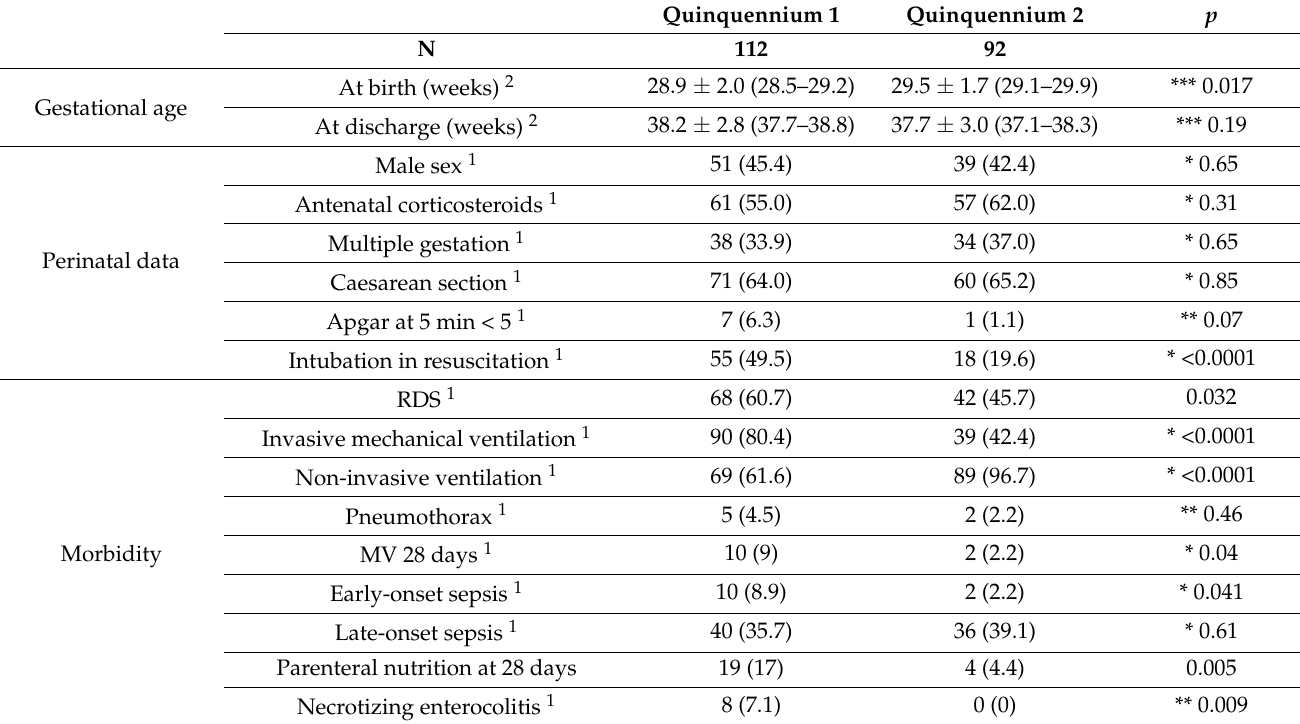
Table 1. Quinquennium 1 (2002–2006) vs. quinquennium 2